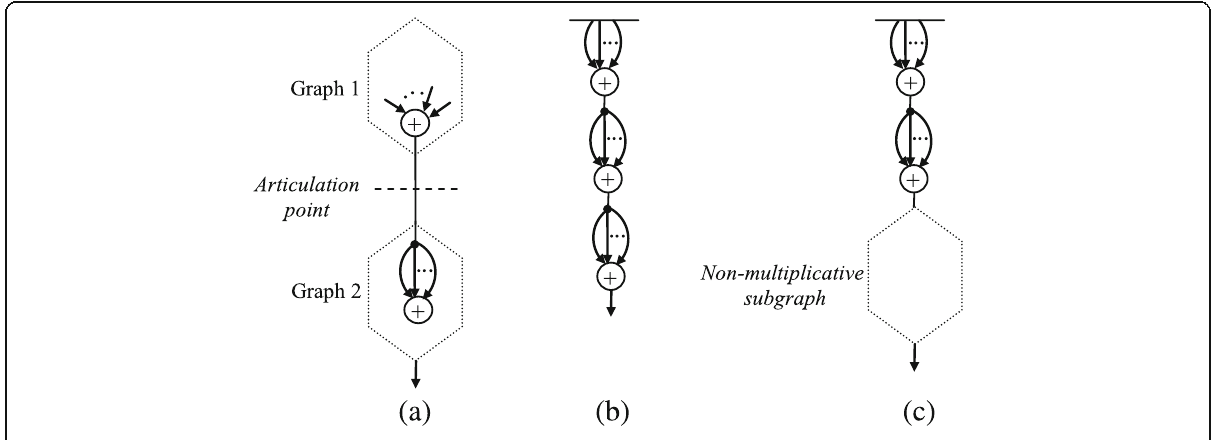
Fig. 5 a multiplicative graph, b completely multiplicative graph, and c generalized